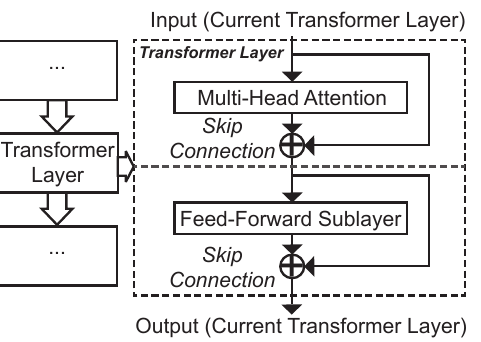
Figure 2. A systematic overview for each transformer layer from the transformer module within the proposed